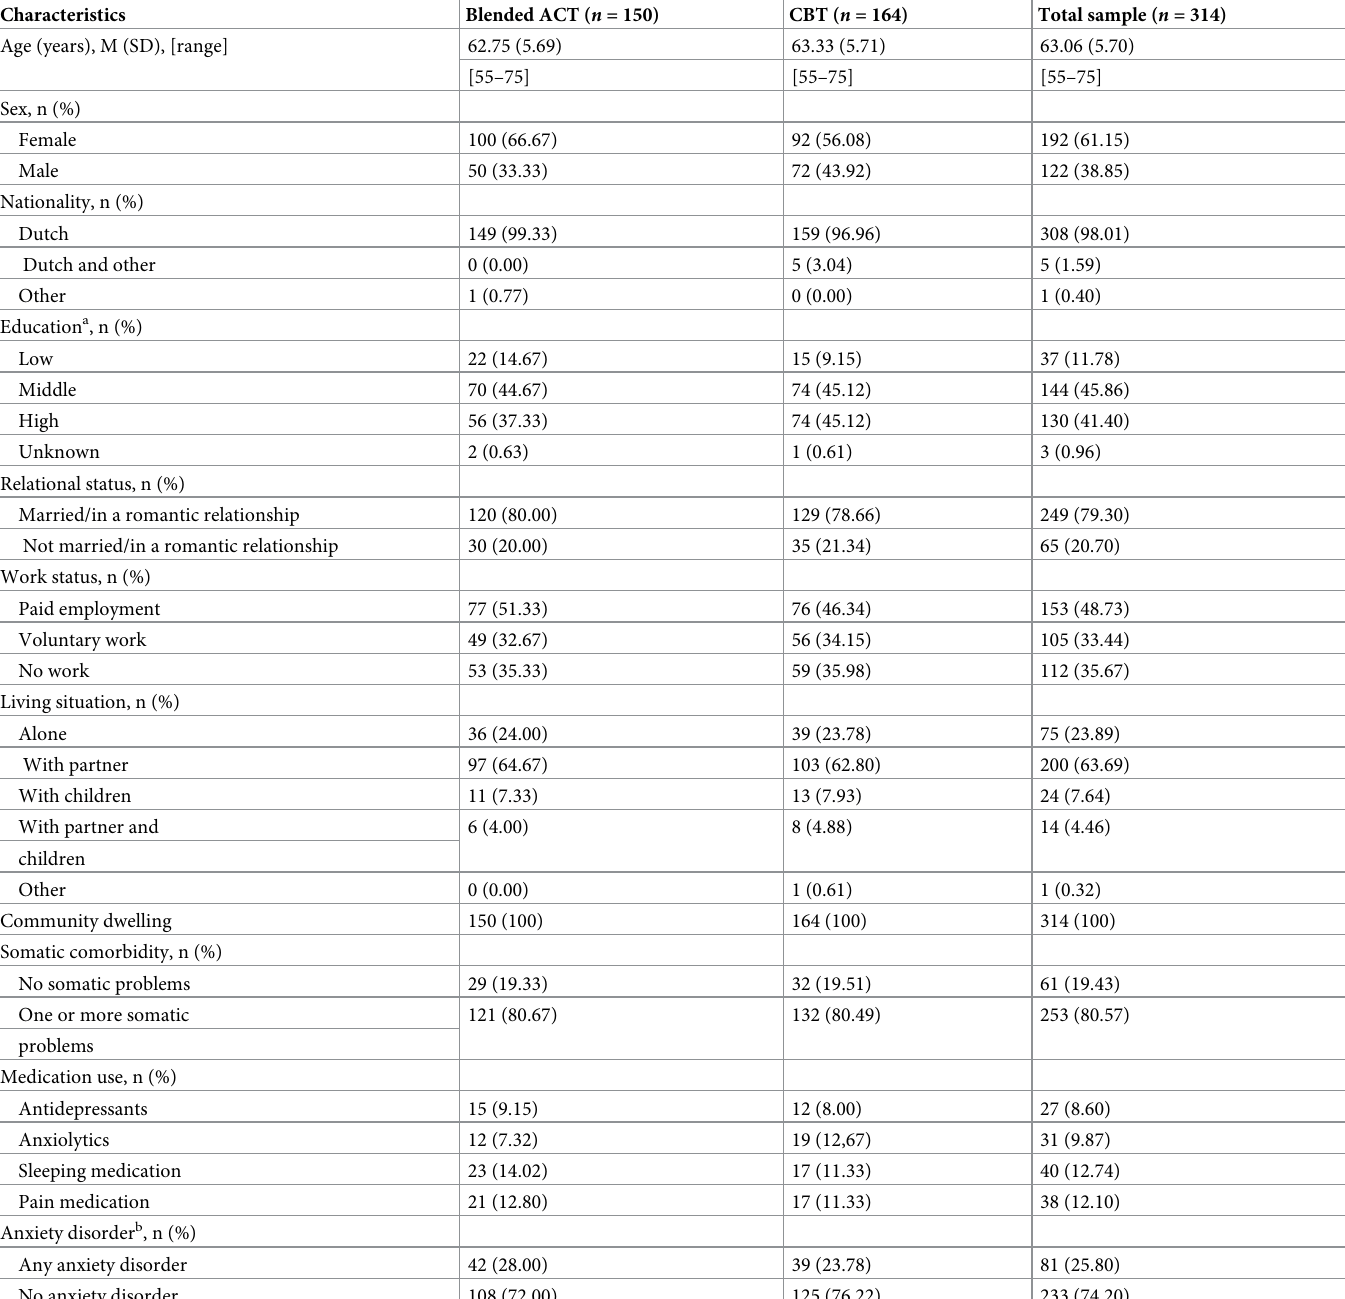
Table 1. Baseline characteristics of study